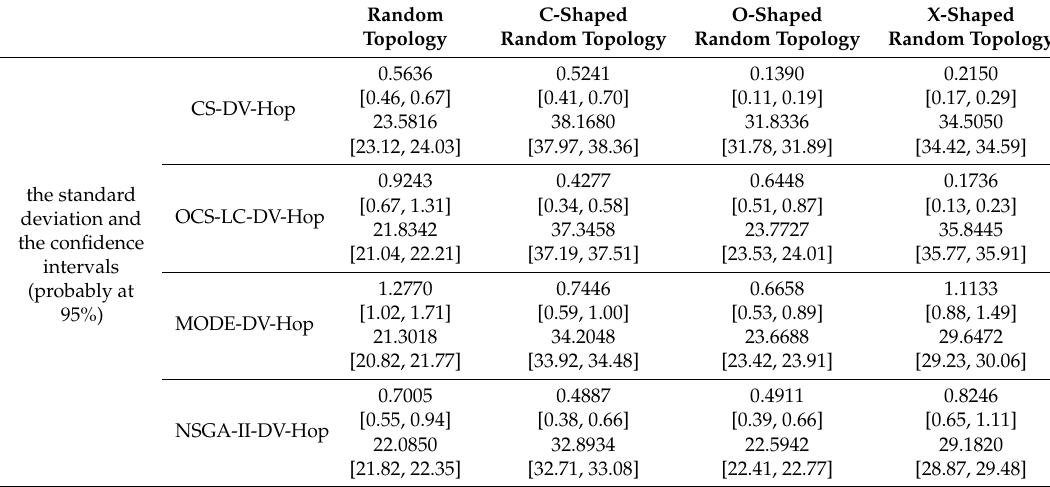
Table 5. The standard deviation and confidence intervals of different algorithms in four network topologies.